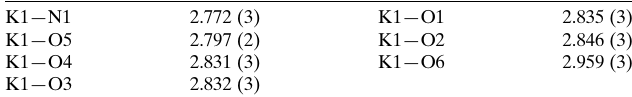
Table 1 Selected geometric parameters (A˚ , (cid:5) ) for 1 . Fe1—C33